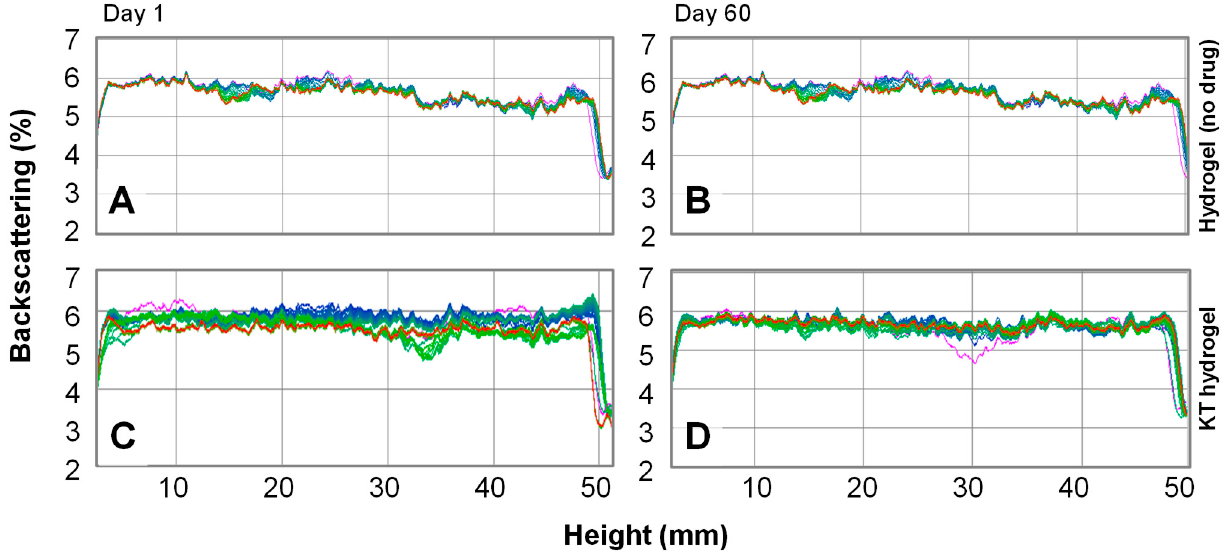
Figure 2. Hourly backscattering profiles over 24 h for ( A ) hydrogel without drug at day 1; ( B ) hydrogel without drug at day 60; ( C ) ketorolac hydrogel (KT hydrogel) at day 1; and ( D ) KT hydrogel at day 60. The color of the lines shows the hourly evolution within the day of analysis, being magenta the first and red the last analysis after the 24-h study.